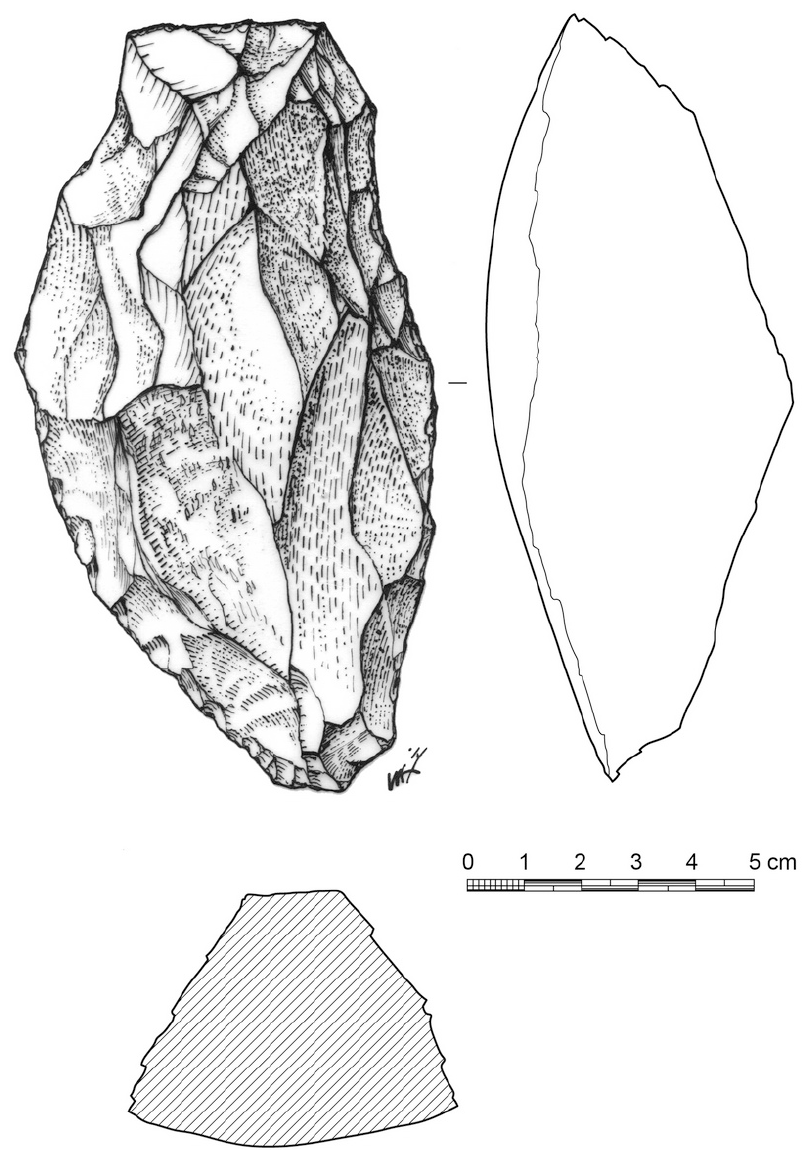
Figure 13. Uniface, Laang Spean (Cambodge). Figure 13. Uniface of Laang Spean,